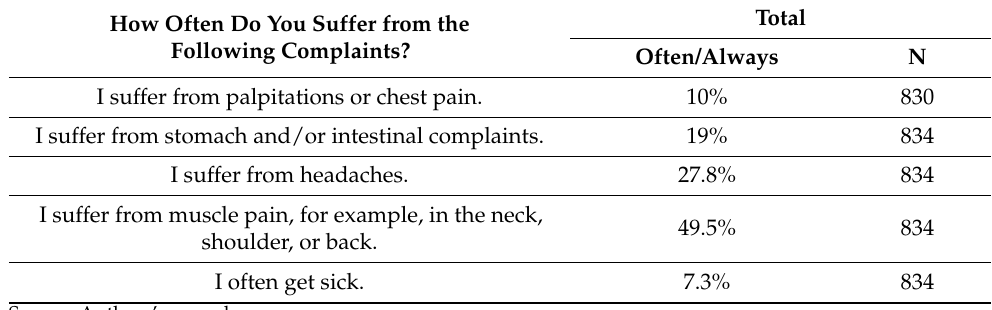
Table 4. Frequeny of Polish school principals’ psychosomatic complaints during the COVID-19 pandemic. Total How Often Do You Suffer from the Following Complaints? Often/Always N I suffer from palpitations or chest pain. 10% 830 I suffer from stomach and/or intestinal complaints. 19% 834 I suffer from headaches. 27.8% 834 I suffer from muscle pain, for example, in the neck, 49.5% 834 shoulder, or back. I often get sick. 7.3% 834